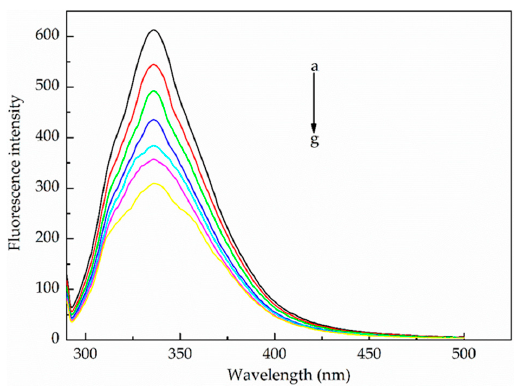
Figure 1. Fluorescence emission spectra of catalase (CAT) with different doses of 2-MT. Conditions: CAT: 1.0 × 10 − 7 mol·L − 1 , 2-MT: 0 mol·L − 1 (a); 1 × 10 − 5 mol·L − 1 (b); 2 × 10 − 5 mol·L − 1 (c); 3 × 10 − 5 mol·L − 1 CAT: 1.0 × 10 − 7 mol · L − 1 , 2-MT: 0 mol · L − 1 (a); 1 × 10 − 5 mol · L − 1 (b); 2 × 10 − 5 mol · L − 1 (c); (d); 4 × 10 − 5 mol·L − 1 (e); 5 × 10 − 5 mol·L − 1 (f); 6 × 10 − 5 mol·L − 1 (g); pH 7.4; T = 291 K. 3 × 10 − 5 mol · L − 1 (d); 4 × 10 − 5 mol · L − 1 (e); 5 × 10 − 5 mol · L − 1 (f); 6 × 10 − 5 mol · L − 1 (g); pH